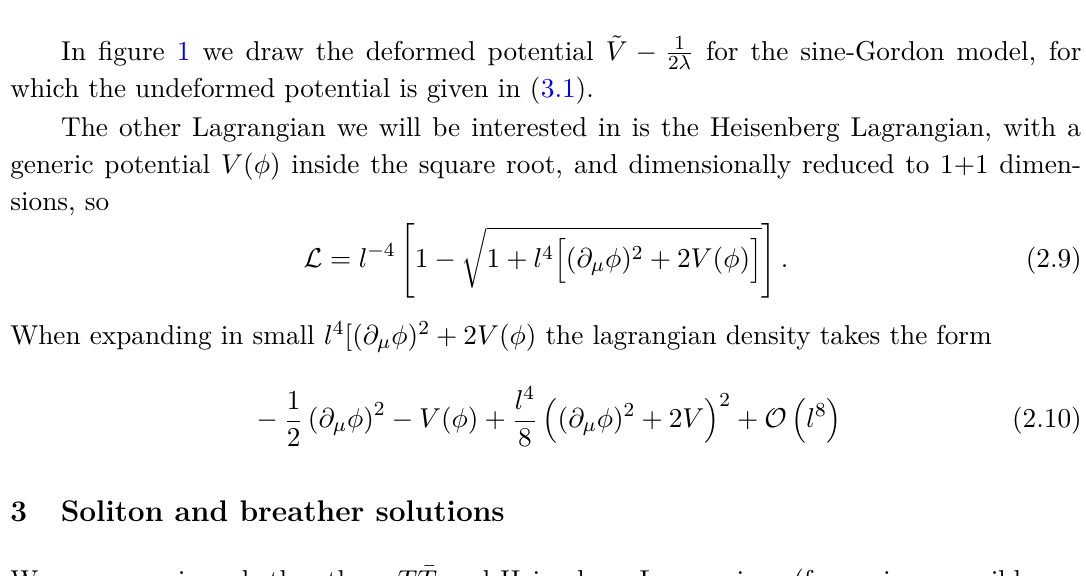
Figure 1 . The potential of the deformed sine-Gordon model with µ = β = 1 for λ = 0 . The undeformed case is in brown, λ = 1 is in blue and λ = 10 is in